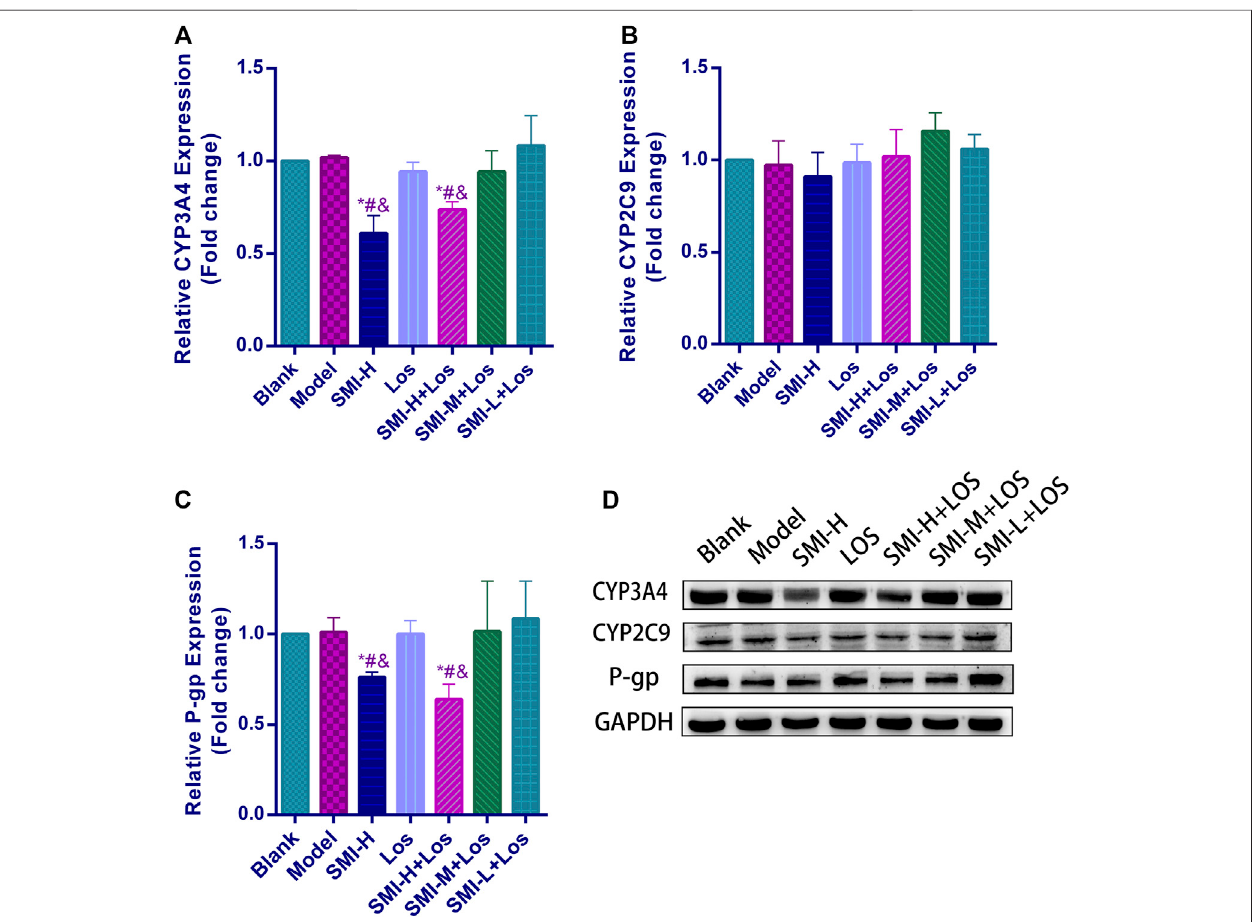
FIGURE3| TherelativeproteinexpressionlevelsofCYP3A4 (A) ,CYP2C9 (B) andP-gp (C) andproteinbandsofthese (D) ineachgroupwithL-NAMEtreatment.* indicates p < 0.05 compared with Blank group; # indicates p < 0.05 compared with Model group; and indicates p < 0.05 compared with LOS group. Model group was treated with L-NAME 60 mg kg − 1 . d − 1 intragastrically; SMI high-dose group (SMI-H group) received SMI 6 ml kg − 1 . d − 1 in tail vein injection; LOS group was given LOS 10 mg kg − 1 .d − 1 byintragastricadministration;LOSplusSMIhigh-dosegroup(SMI-H+LOSgroup),LOSplusSMImedium-dosegroup(SMI-M+LOSgroup)and LOS plus SMI low-dose group (SMI-L + LOS group) were respectively given SMI 6 ml kg − 1 . d − 1 , 4 ml kg − 1 . d − 1 , 2 ml kg − 1 . d − 1 in tail vein injection, based on LOS 10 mg kg − 1 . d − 1 intragastrically.